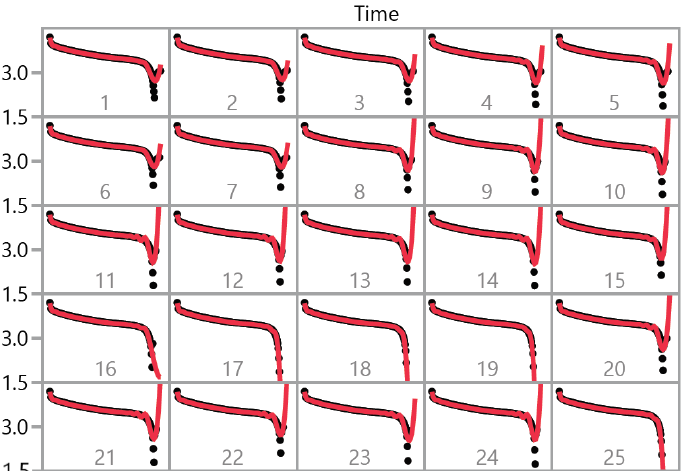
Figure 2. B-spline fitted for the first 25 cycles of voltage curves.